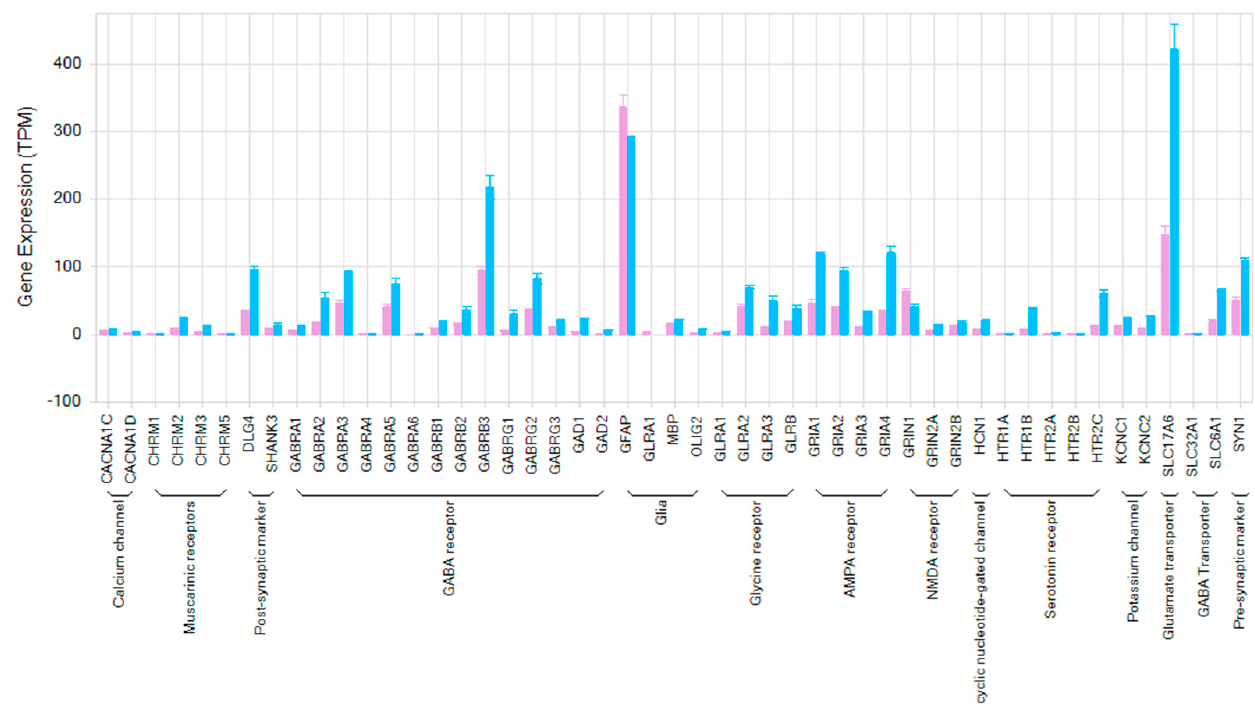
Figure 6. Bar plot showing in Transcript per Million (TPM) expression levels of 48 key selected neuronal genes in hiPSC-derived neurons with human primary astrocytes in 2D (pink) and 3D spheroids (blue).